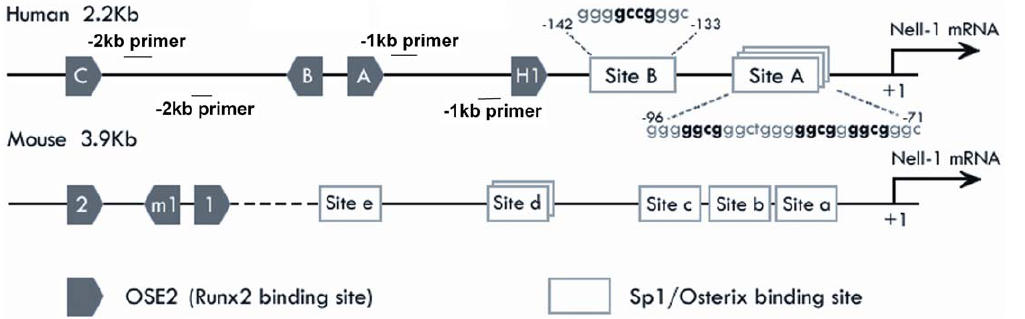
Figure 1. Schematic of the human and mouse Nell-1 promoters (not drawn to scale). In silico analysis identified a cluster of potential Sp1/ Osterix binding sites within approximately 70 bp of the 5 9 flanking region of the human NELL-1 gene. Within the cluster, Site A contains three overlapping potential Sp1 sites from 2 71 to 2 96 bp and Site B contains a single Sp1 site from 2 133 to 2 142 bp. Four OSE2 sites to which Runx2 binds in human NELL-1 promoter are also shown (labeled A, B, C and H1). A similar pattern is seen in mouse Nell-1 promoter. Multiple putative Sp1 sites (labeled Site a , e) are located before three OSE2 sites (labeled 1, m1 and 2). The relative location of primers for CHIP assay are indicated on the human 2.2 kb